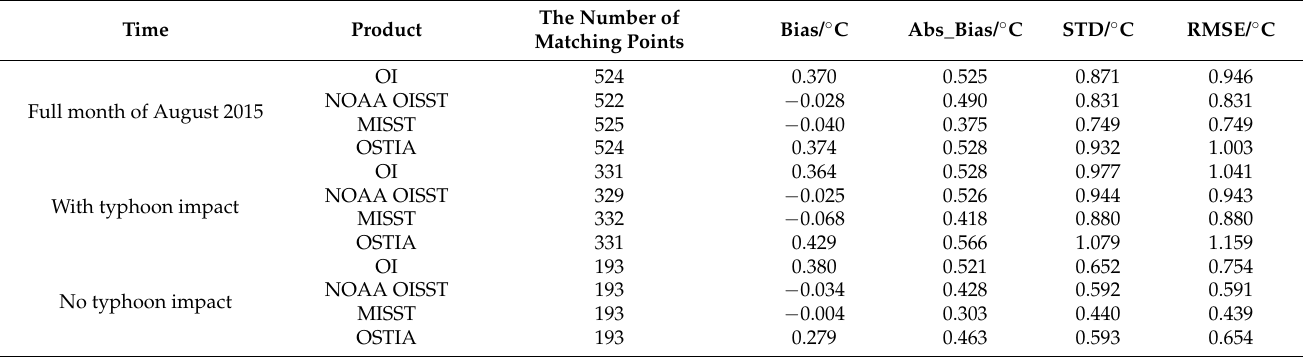
Table 2. Statistical analysis of the matching points among four kinds of SST products.